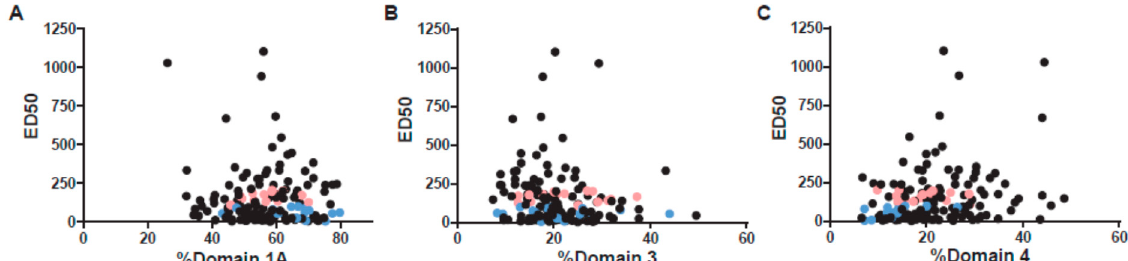
Figure 6. Anti-PA domain specificity in all 144 individuals. To account for large differences in total anti-PA IgG in the entire group of 144 individuals, domain concentrations were expressed as the percent of ( A ) anti-domain 1A and ( B ) anti-domain 3 with respect to the total of all three domains (1A + 3 + 4). Anti-domain 1A is not correlated with ED50 ( r s = − 0.034; p s = 0.688), anti-domain 3 shows a weak negative correlation ( r s = − 0.184; p s = 0.028). ( C ) The anti-domain 4 percentage shows a positive correlation with ED50 ( r s = 0.230; p s = 0.0057). All comparisons were calculated using Spearman’s correlation. The black dots are from the total cohort; from this cohort, data from high neutralizers from the matched cohort are shown in pink; data from low neutralizers are shown in blue.